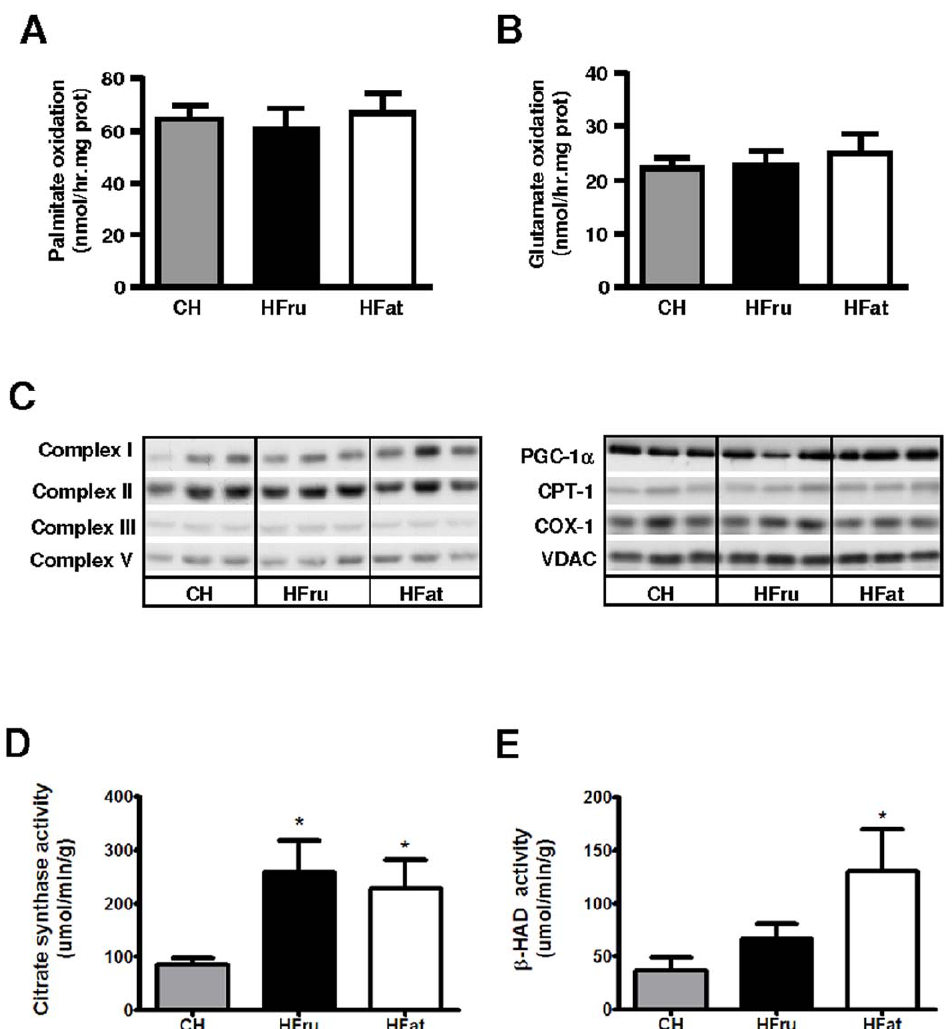
Figure 4. Effects of HFru and HFat feeding on mitochondrial oxidation, key protein expressions and enzymatic activities. After one week of HFru or HFat feeding, the rates of hepatic oxidation of palmitate ( A ) and glutamate ( B ) were measured in liver homogenates using [1- 14 C]- palmitate or [1- 14 C]-glutamate as substrates. Data are mean 6 SE from 6 mice per group. ( C ) Levels of key proteins for mitochondrial oxidation, biogenesis and numbers were measured by immunoblots. Each lane represents a single mouse, 6 mice per group. The specific activity of citrate synthase ( D ) and b -HAD ( E ), data are mean 6 SE from 6 to 8 mice per group. * p , 0.05 vs CH.